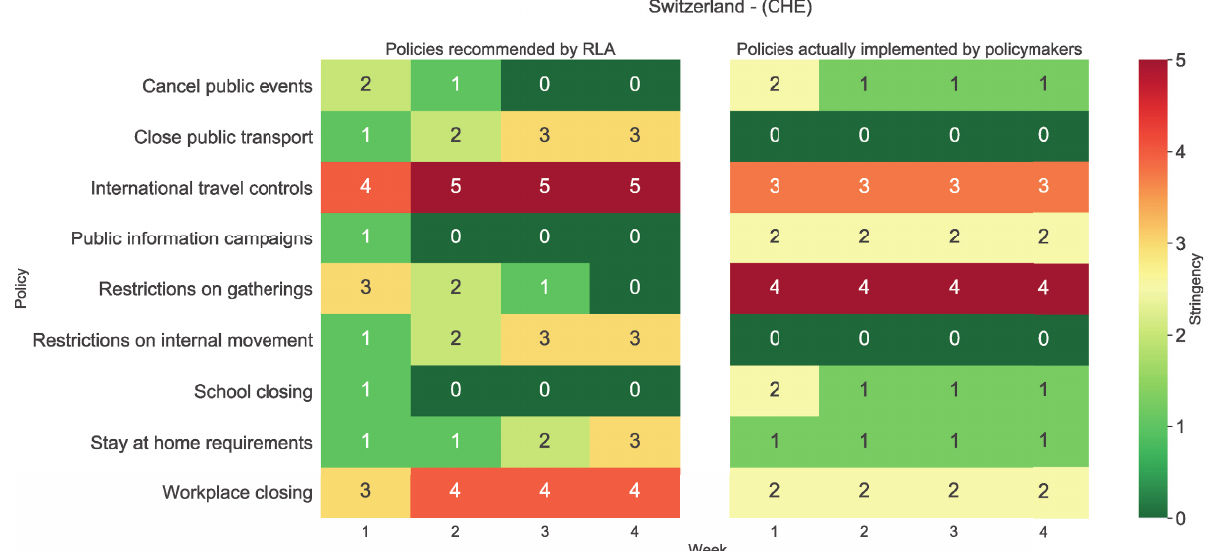
Fig 8. Predicted best policy mix for Switzerland. Starting from 12/04/2021 (included) for the following 28 days, compared to the actual implemented policies. Each of the nine policies are either not implemented (stringency of zero in green) or implemented in one of five levels of stringency (shaded green ! yellow !